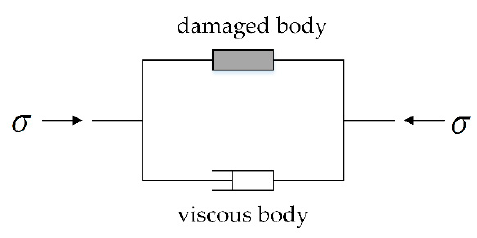
Figure 10. Visco-elastic damage model.